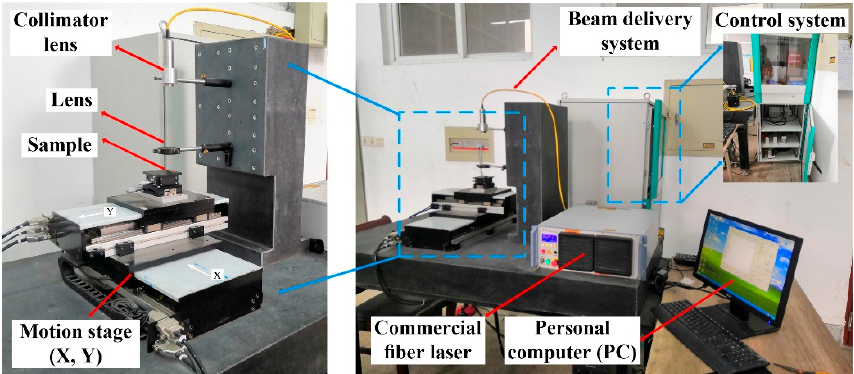
Figure 2. Experimental device of laser surface micro-structuring.